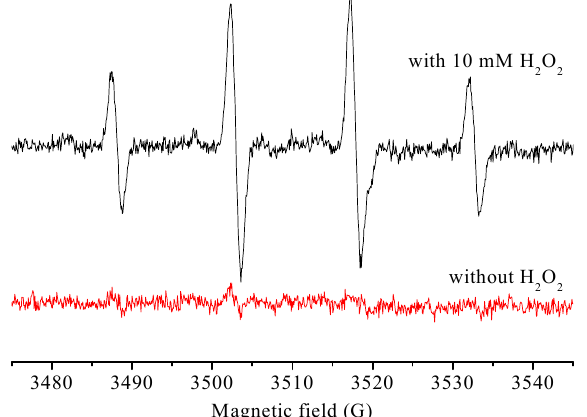
Figure 10. DMPO spin-trapping EPR spectra of reactive red X-3B dye solution (initial concentration: 1 × 10 − 4 mol/L, CoPc@BC: 1.60 mg, T = 50 °C).